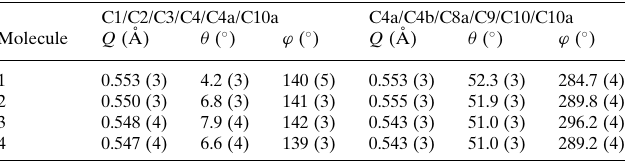
Puckering amplitudes (Cremer & Pople, 1975) for the non-benzenoid rings in the four independent molecules.